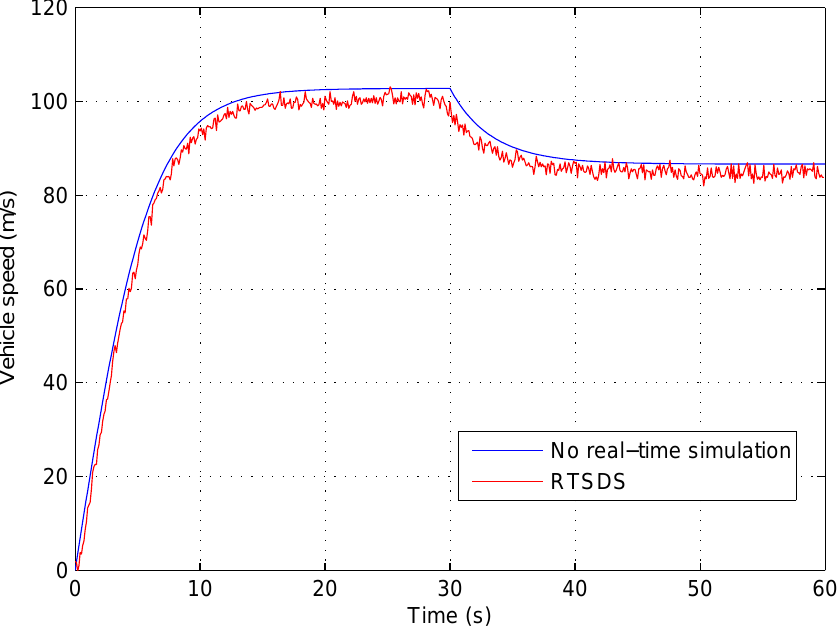
Figure 23. Results obtained for the RTSDS platform utilizing an external PID